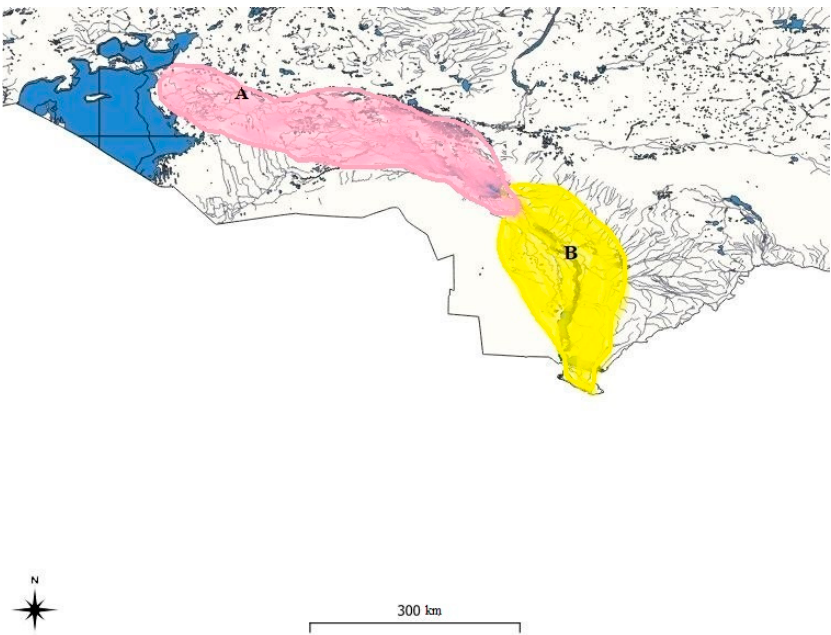
Figure 1. Distribution of the Aral barbel Luciobarbus brachycephalus Kessler, 1872 ( A ) and Bulatmai barbel Luciobarbus capito Güldenstädt, 1773 ( B ) in Aral—Syrdarya basin (Kazakhstan).